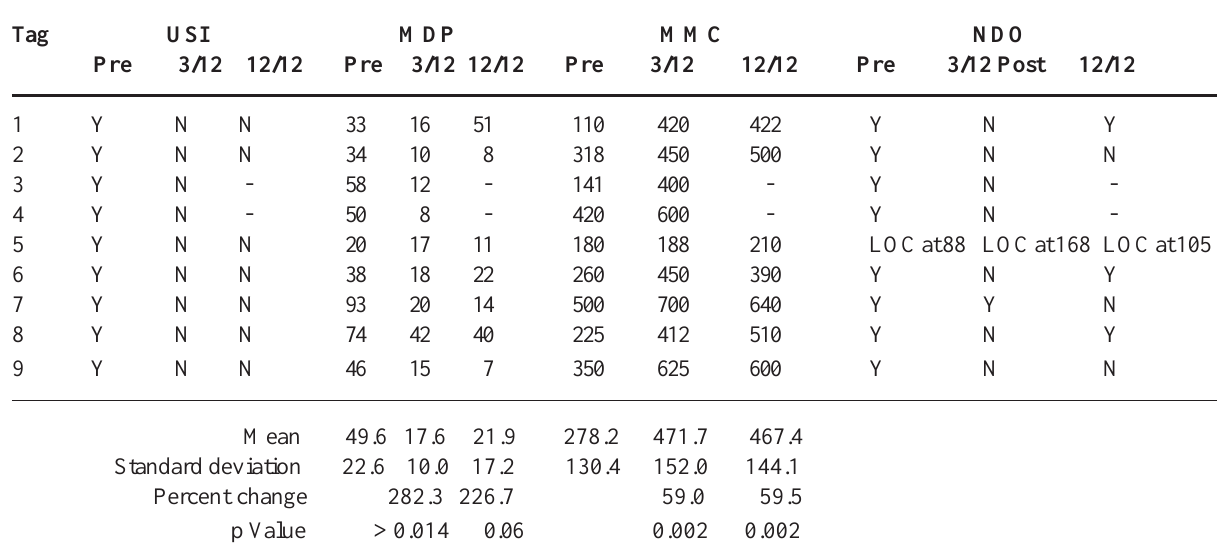
Table 3 – Urodynamic parameters pre- and postoperation.